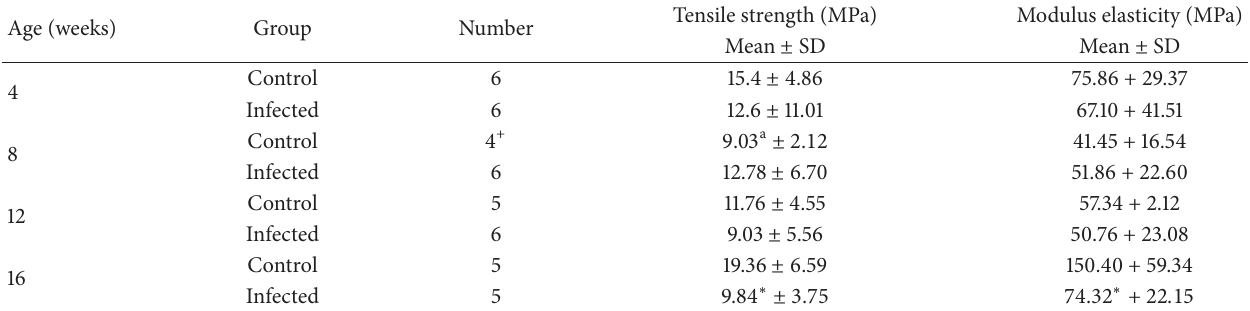
Table 1: Average tendon tensile strength and elasticity of turkey gastrocnemius tendons at different time points. Age